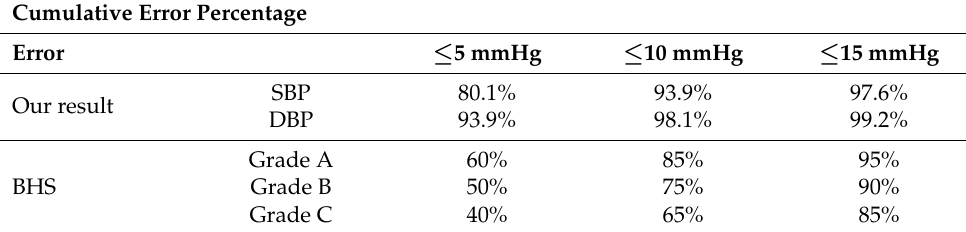
Table 2. Comparison result with BHS